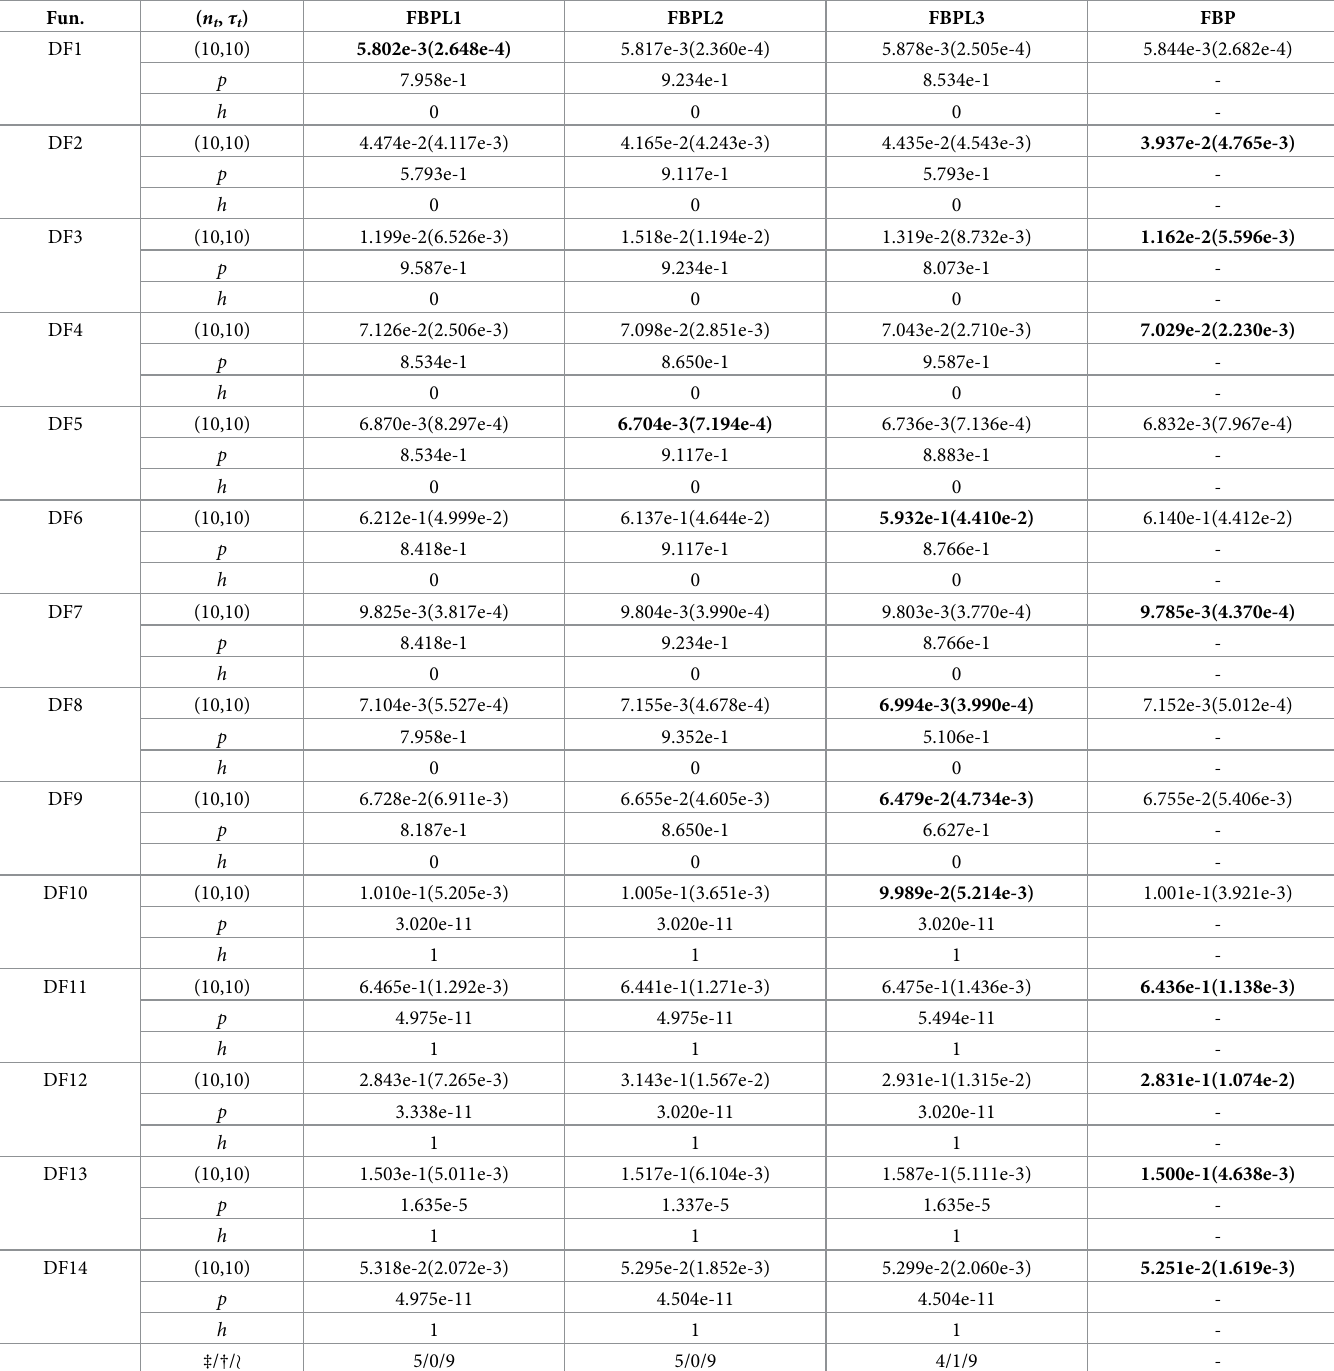
Table 15. Performance comparison of FBP variants on MIGD for ( n t , τ t ) = (10,10).